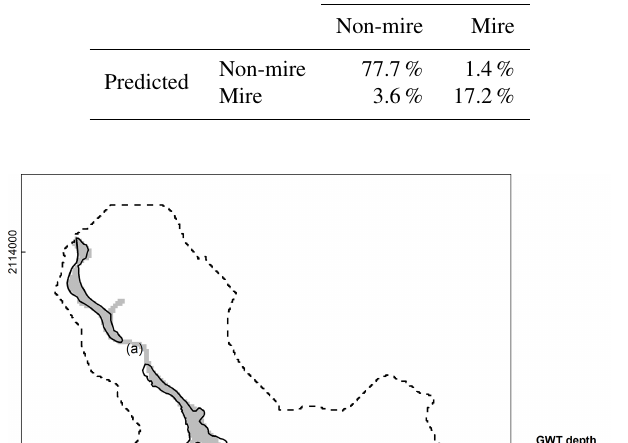
Table 4. Confusion matrix between the observed mire distribution based on botanical (Durepaire and Guerbaa, 2008) and pedological (Duranel, 2015) criteria and the predicted mire distribution based on model results (simulated mean annual groundwater level > 0 . 166m below ground level for the period 2001–2013), in % of the total number of grid cells. Observed